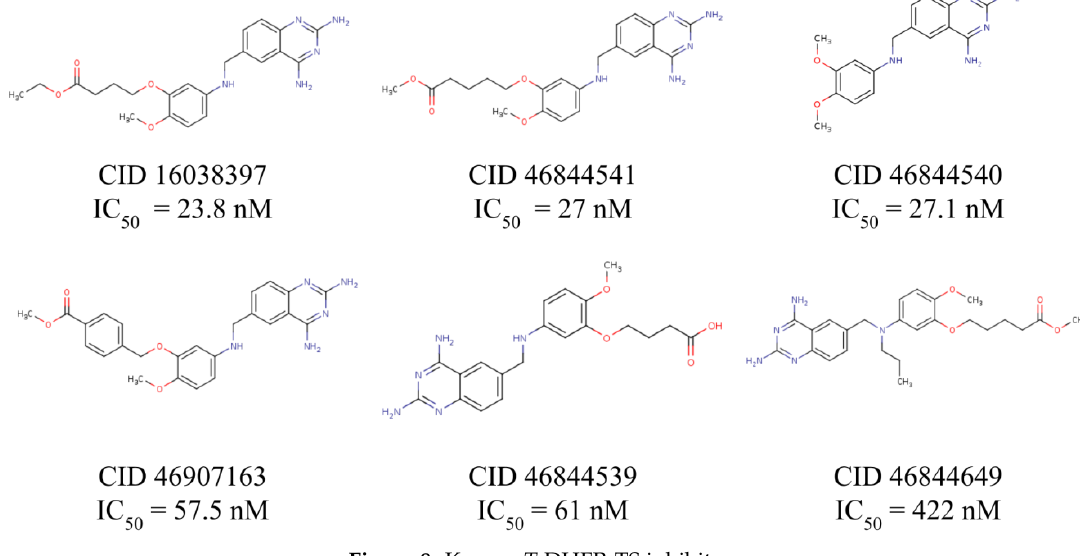
Figure 8. Known Tc DHFR-TS inhibitors.